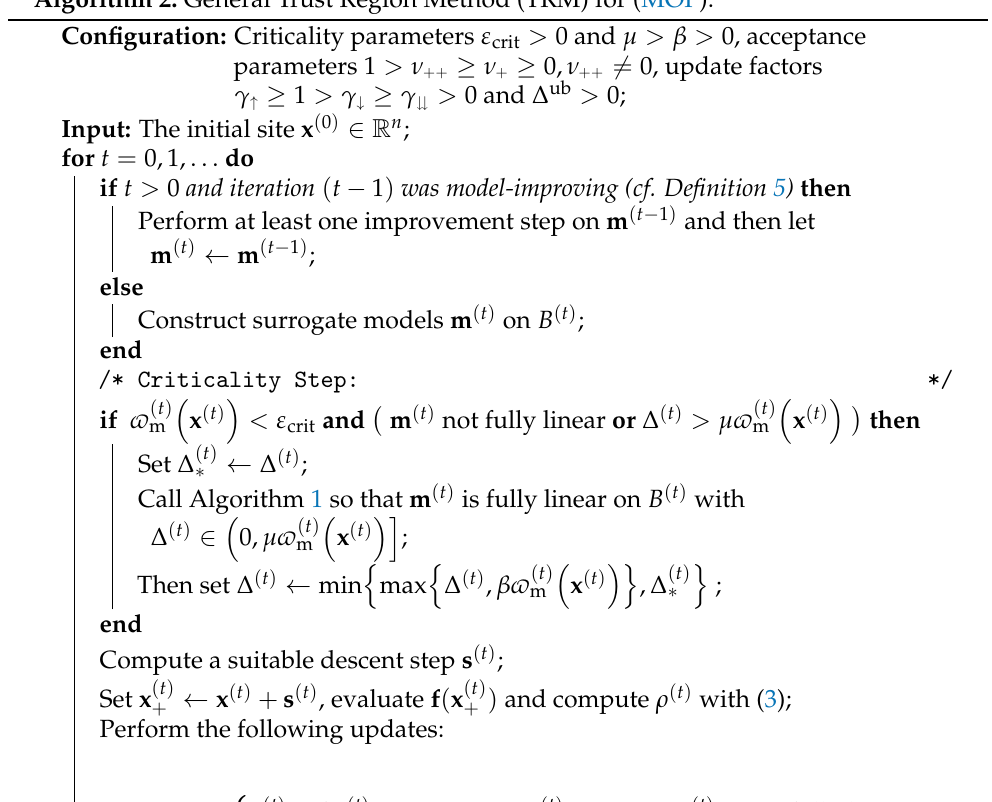
Algorithm 2: General Trust Region Method (TRM) for